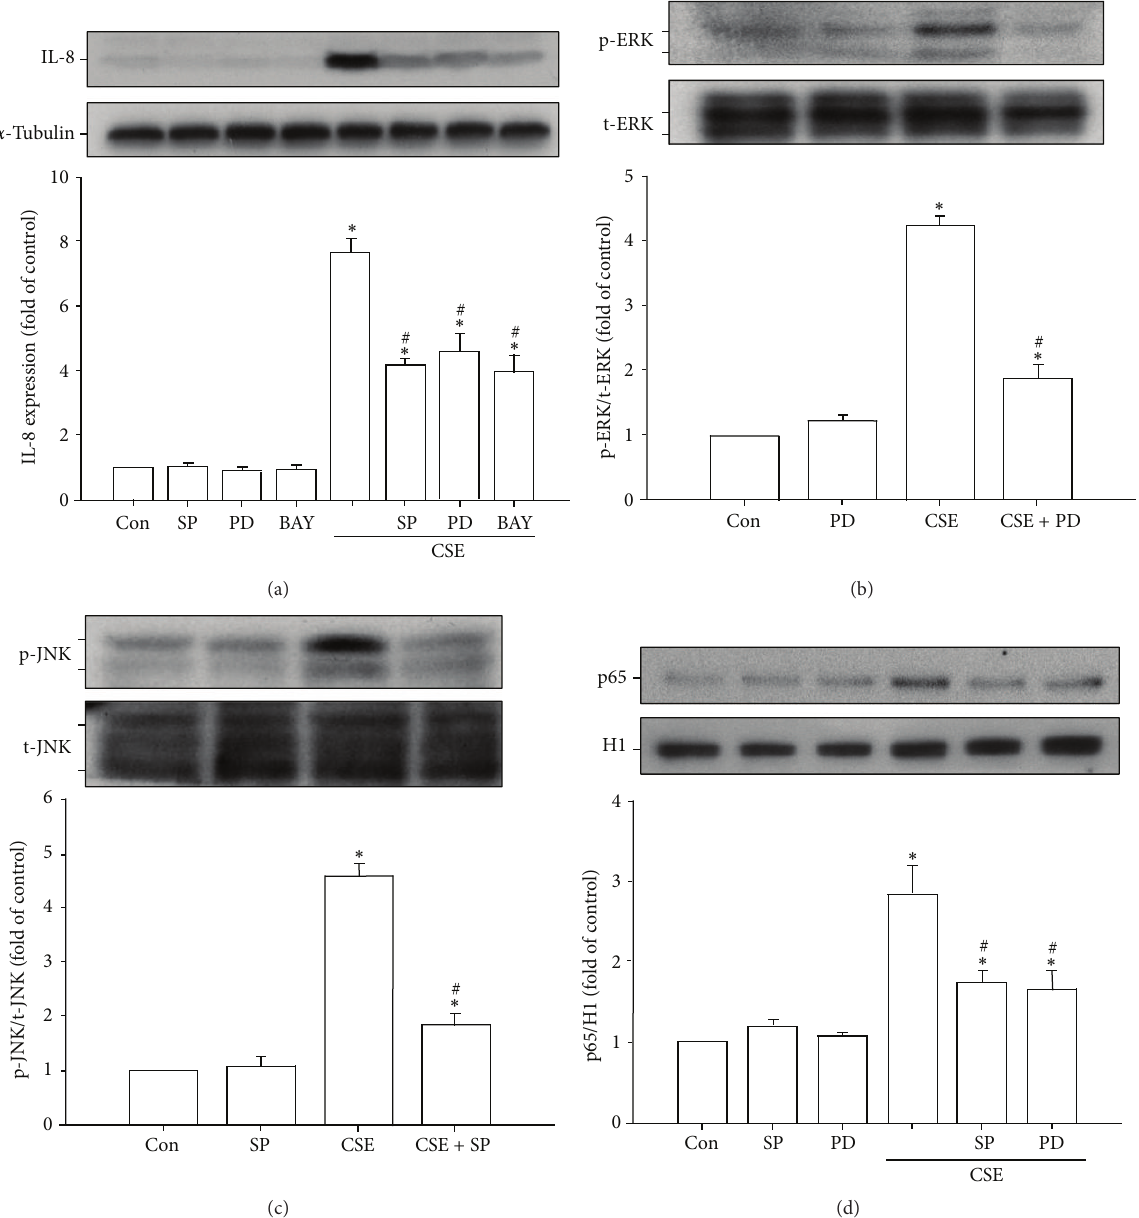
Figure 7: The ERK, JNK, and NF- 𝜅 B signaling is crucial for the induction of IL-8 by cigarette smoke extract (CSE) in human bronchial epithelial cells. Cells were exposed to medium alone or 3% CSE for 24 (a), 6 ((b), (c)), or 12 hours (d) with pretreatment with an ERK inhibitor (PD98059; PD, 10 𝜇 M), a JNK inhibitor (SP600125; SP, 10 𝜇 M), or a NF- 𝜅 B inhibitor (BAY 11-7085; BAY, 10 𝜇 M). Protein expression was analyzed by Western blotting. Activation of ERK (b) or JNK (c) was indicated by increased phosphorylation of these kinases in cell lysates, whereas activation of NF- 𝜅 B (d) was indicated by increased presence of p65 subunit in the cell nucleus. ∗ 𝑃 < 0.05 versus control (Con). # 𝑃 < 0.05 versus CSE without inhibitor